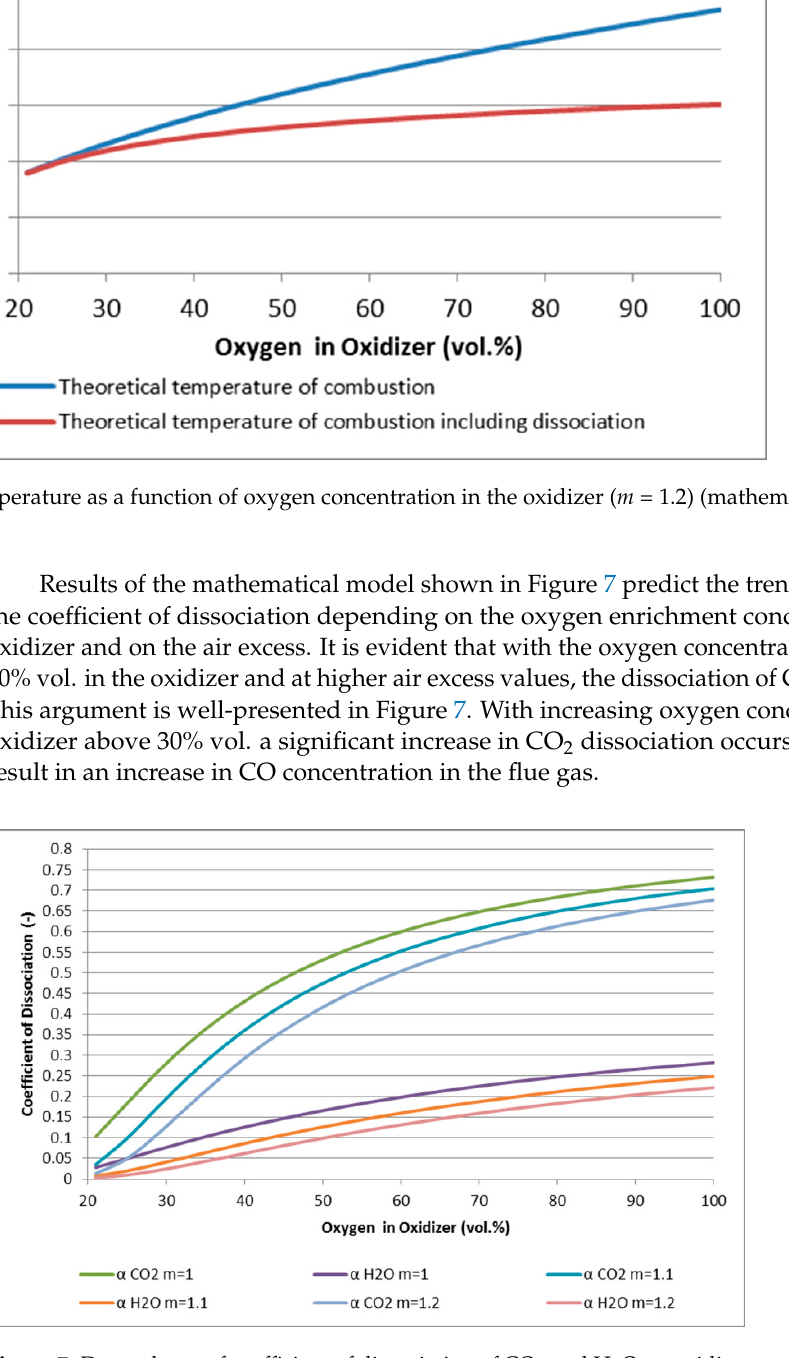
Figure 8. Dependence of CO concentration in flue gas on concentration of oxygen in oxidizer (ex- perimental measurements). 4.3. Emissions of NO x Figure 9 shows that in both burner design cases the nitrogen oxide emissions increased as the oxygen concentration in the oxidizer rose. The addition of oxygen together with an optimized burner orifice caused the concentration of NO x in flue gas to increase, namely from 5 ppm (21% vol. O 2 ) to 327 ppm (38.74% vol. O 2 ). In the case of the constant burner orifice, an increase in NO x concentration in flue gas from 5 ppm (21%vol. O 2 ) to 860 ppm (43% vol. O 2 ) could be seen. The ex- planation for such a steep increase in NO x concentration in the flue gas is that the burner is placed in a zone with high infiltration of air into the furnace. In addition, due to the increasing combus- tion velocity, the flame becomes shorter. The formation and amount of nitrogen oxides are strong- ly temperature-dependent. The mechanism of NO x formation occurs at a temperature of about 1000 to 1300 K, and with increasing temperature the NO x concentration increases significantly. High flame temperature and large amounts of extra oxygen and nitrogen from air infiltration cre- ate suitable conditions for NO x formation [24].